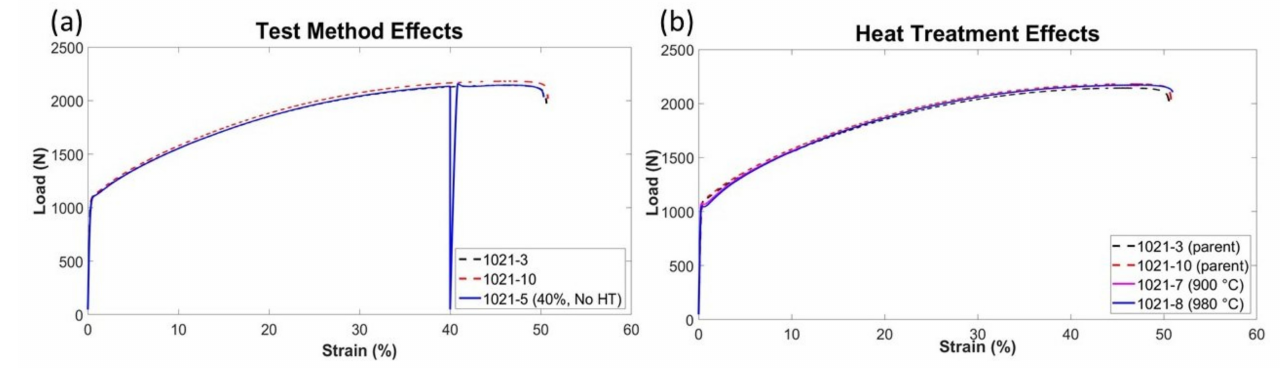
Figure 2. Graphs to validate the ( a ) test method and ( b ) heat treatment.